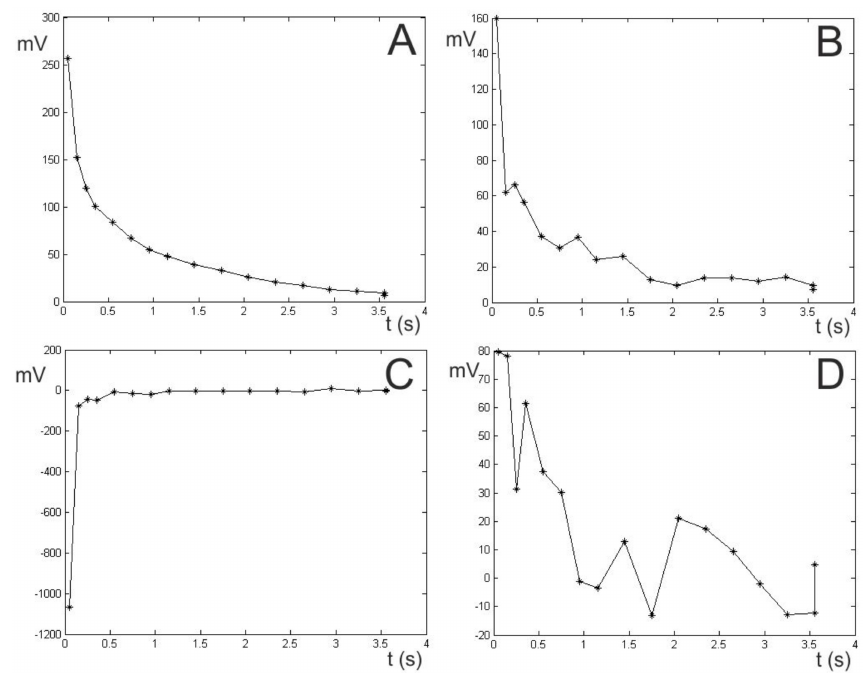
Figure 4. Typical chargeability decay curves (Time domain induce polarization (IP)). ( A , B ) exponential curves type are kept while non-exponential decreasing curves ( C , D ) type are